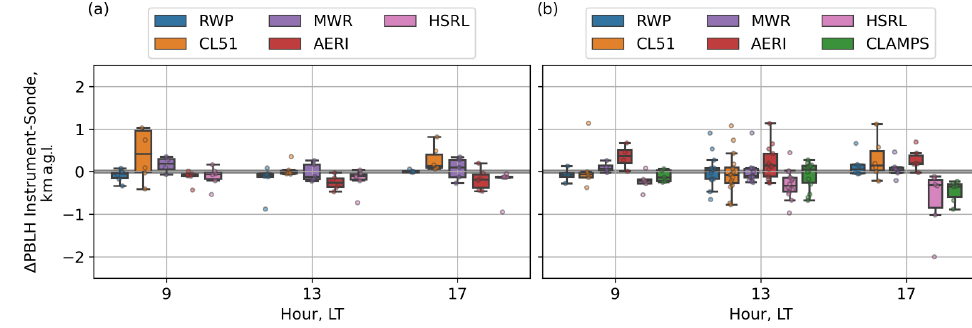
Figure 14. The same as in Fig. 10 but for all instruments involved in the (a) Summer-IOP and (b) Fall-IOP analysis.